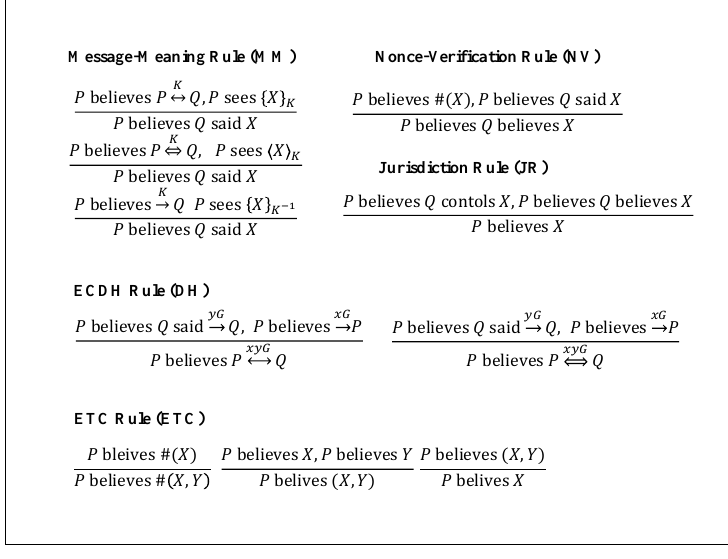
Figure 6. BAN logic